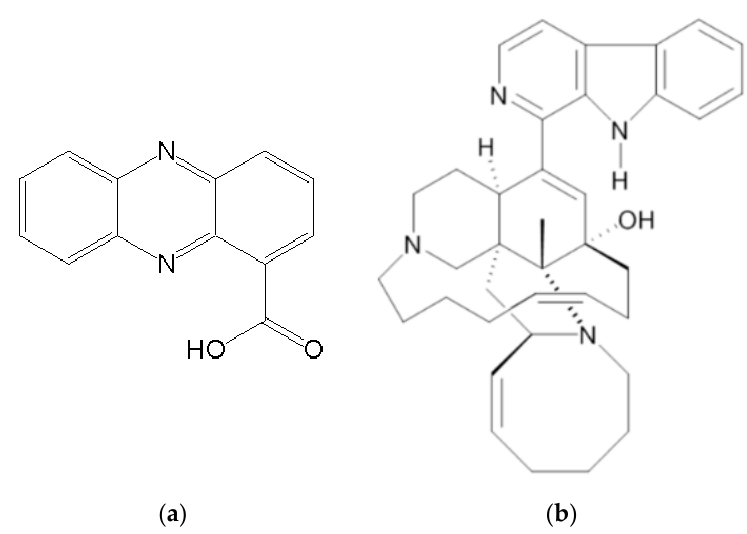
Figure 4. The molecular structures of compounds produced by sponge-associated bacteria ( a ) Figure phenazine-1-carboxylic acid with antibacterial activity [168] and ( b ) manzamine A with antiprotozoal activity [122,164].